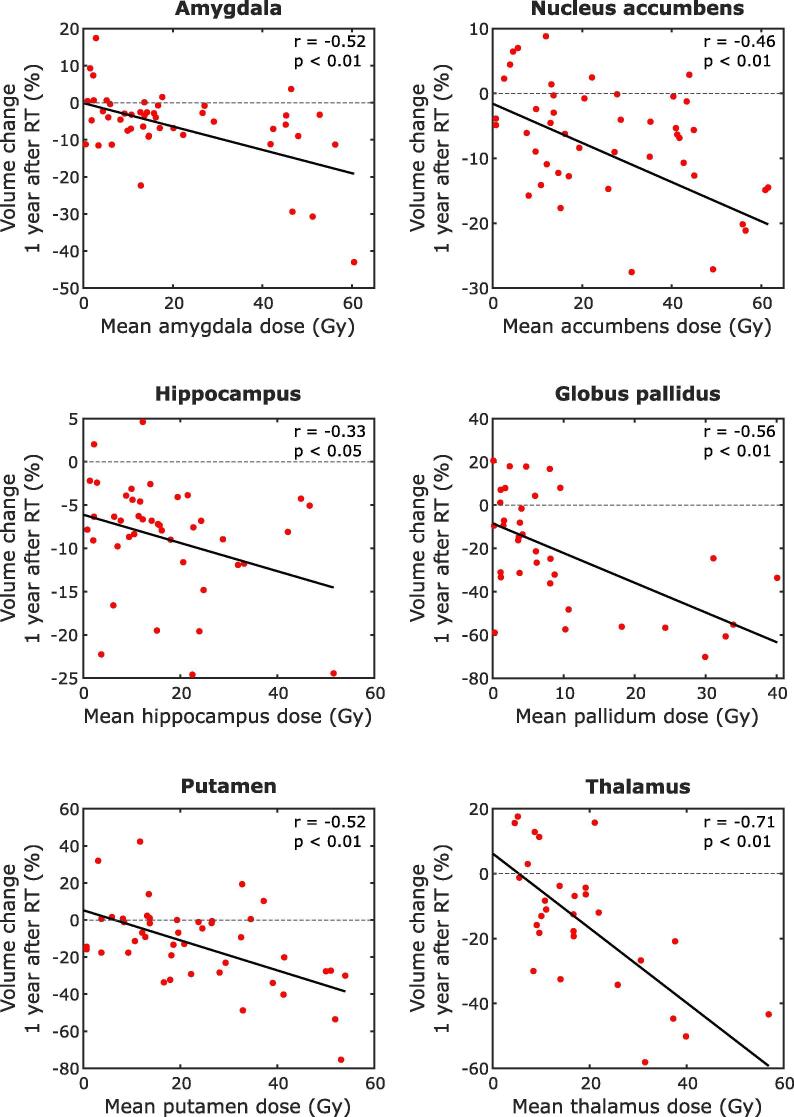
Scatterplots showing the relation between mean RT dose and volume loss in the structures where this was significant, with fitted linear regression lines.